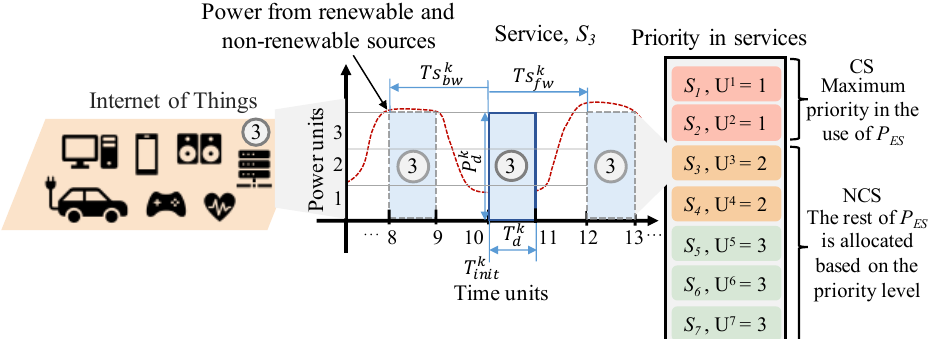
Figure 4. Graphical representation of a service and interaction with the available power. Parameters of S 3 : N = 1, L = 3, l = 2, P 3